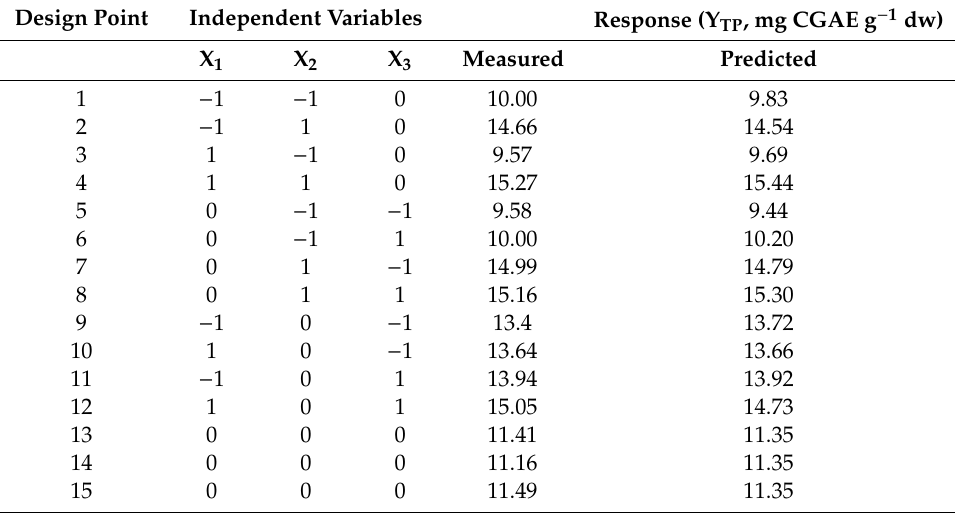
Figure 2. Desirability function ( A ), actual-by-predicted plot ( B ) and statistical information (lack-of-fit and parameter estimates inset tables) generated by performing response surface methodology, concerning the effect of process variables on the response. Asterisks (*) on the “Parameter Estimates” inset table denote statistically significant terms ( p < 0.05). Table 2. Analytical display of individual design points and measured and predicted values of the response.